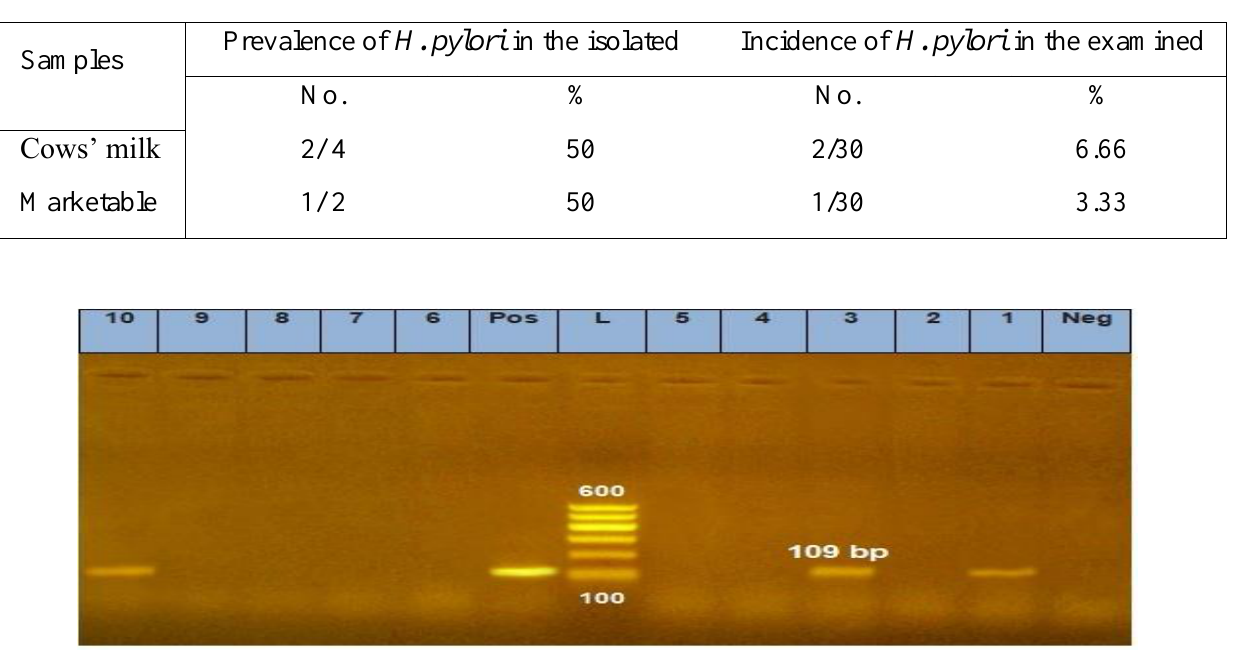
Fig. 1: Molecular identification of the isolated H. pylori strains by using PCR.